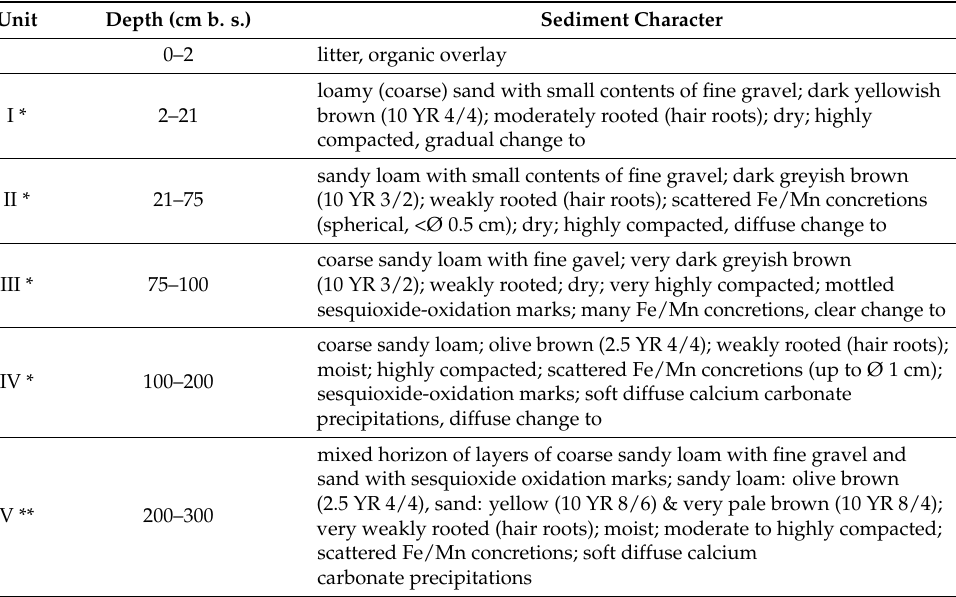
Table 5. Sediment characteristics drilling